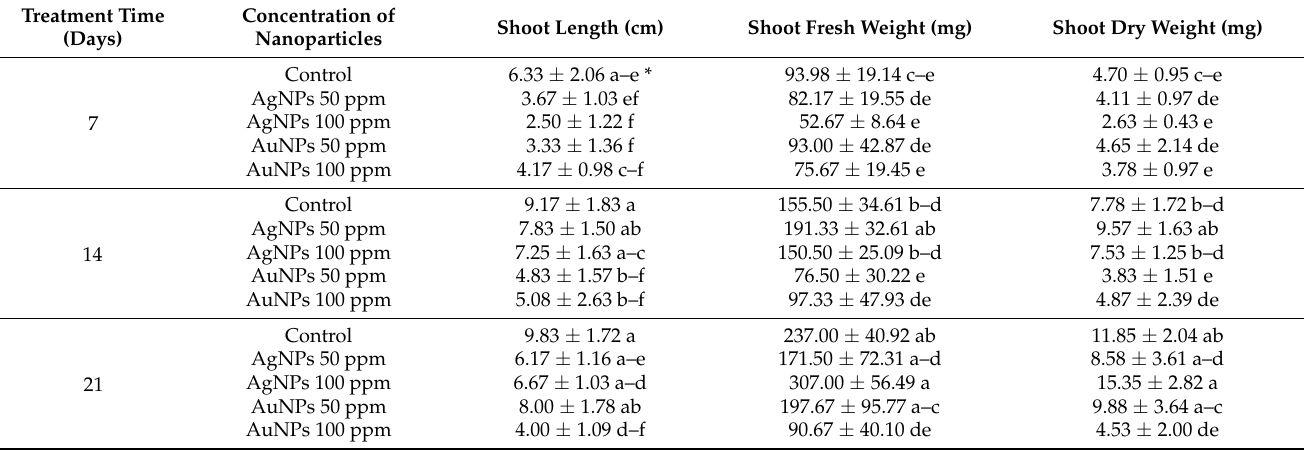
Table 1. Comparison of the influence of nanoparticles’ type and concentration on the shoot length and fresh and dry weight of rapeseed